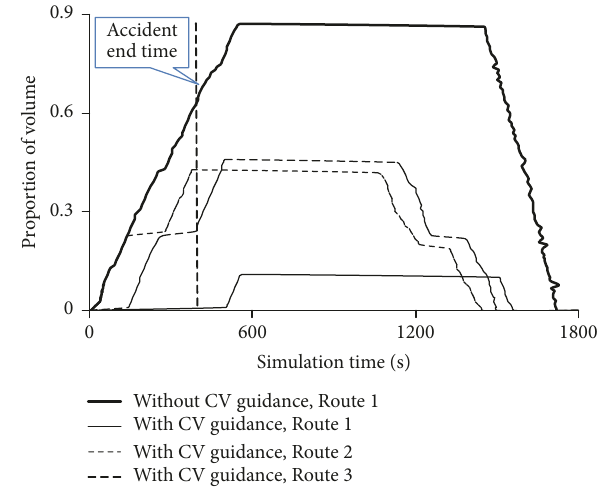
Figure 5: Traffic conditions of the road